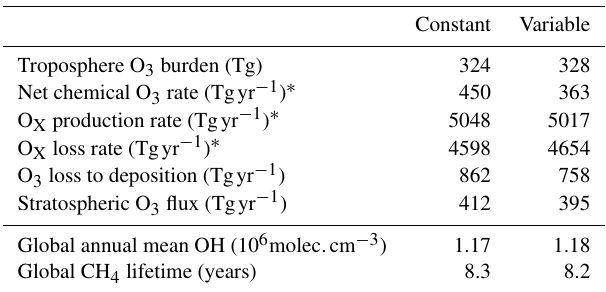
Table 2. Summary of change to atmospheric oxidative capacity for GEOS-Chem using the default (constant) scheme for calculating r c and the new scheme (variable) for 2014.